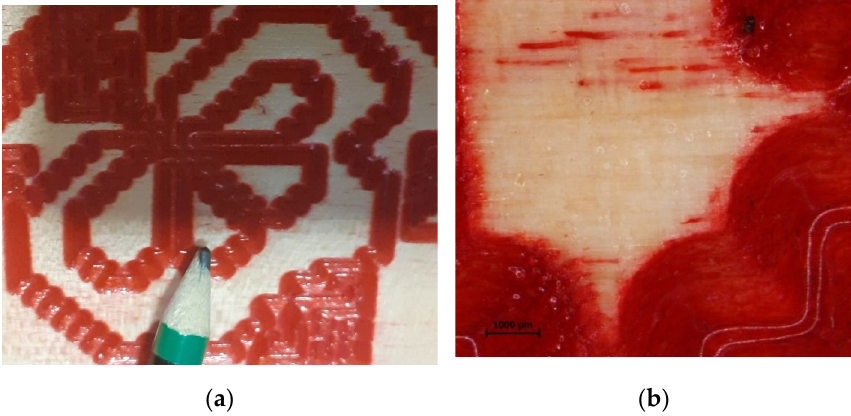
Figure 15. Defects of the wood surface when coloring the ornament: ( a ) Marked area of the wood surface where colorations occur; ( b ) Microscopic detail of the marked surface (22.5× magnification).